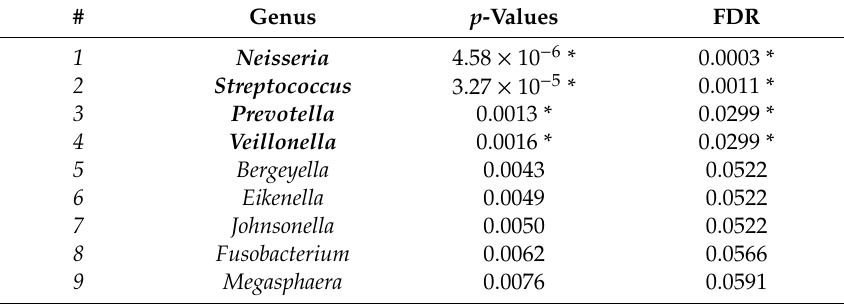
Table 4. The critical features identified by Univariate analysis at the Genus